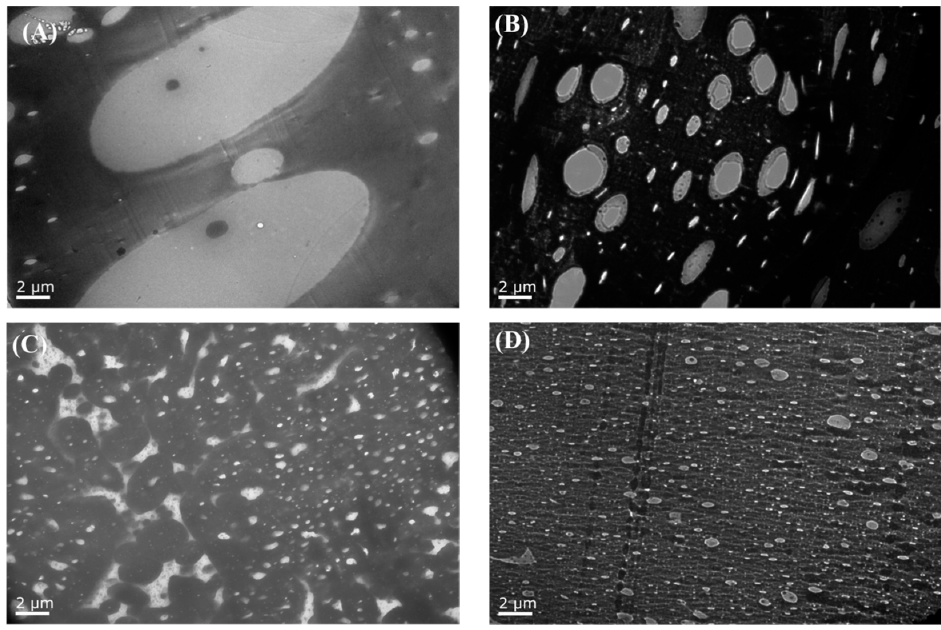
Figure 11. TEM images ( × 1000) of PETG/PGA/ADR (65/35/x; x = 0 ( A ), 0.3 ( B ), 0.6 ( C ), and 0.9 ( D )) samples.